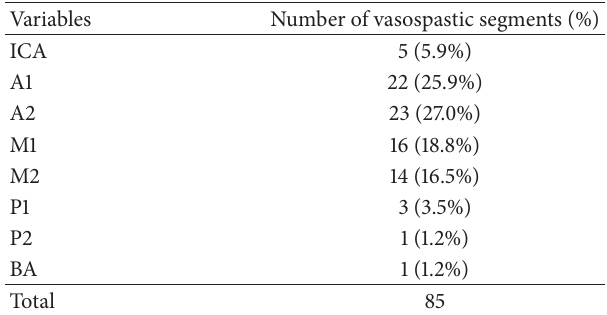
Table 2: Distribution of vasospastic vessel segments ( > 30% luminal narrowing) demonstrated by digital subtraction angiography.